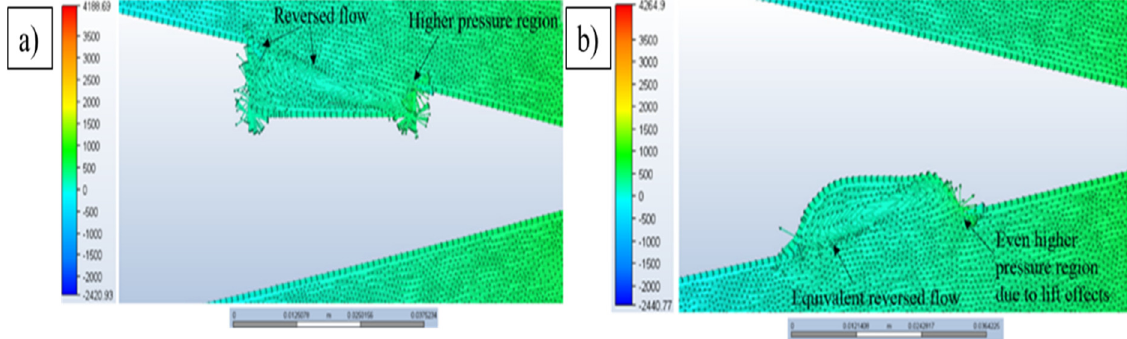
Figure 18. Exploded views showing ( a ) visualisation of the increased levels of drag induced by a square dimple and ( b ) flow phenomenon when a dimple is placed underneath the aerofoil.